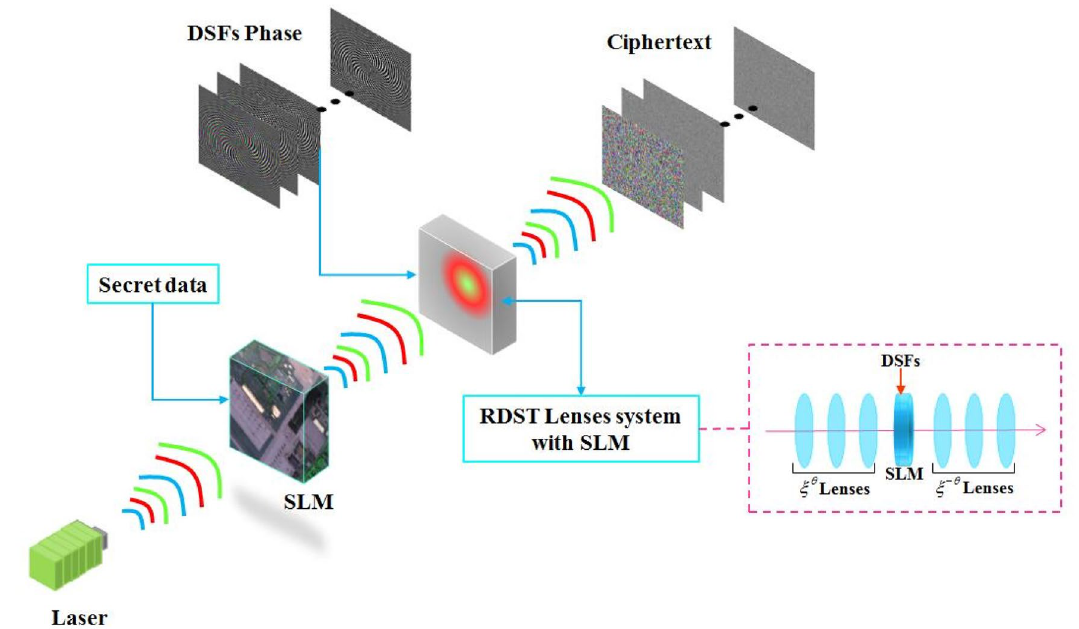
Figure 4. The Schematic diagram of the hybrid optoelectronic